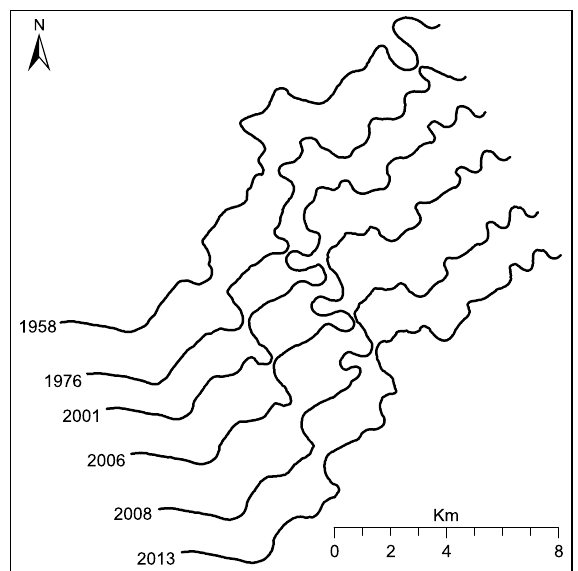
Fig. 4. Successive channel planform changes from 1958 to 2013 along the reaches of Bosna